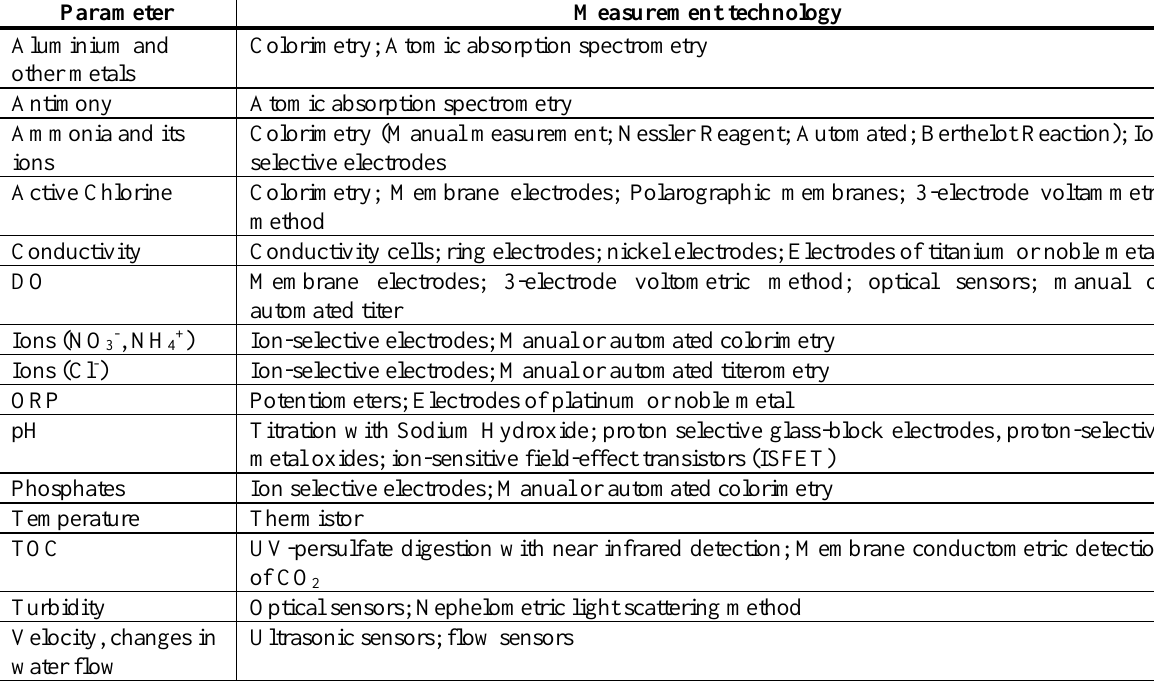
Table 2. The most frequently measured water parameters and associated sensing technologies (based on [8] and